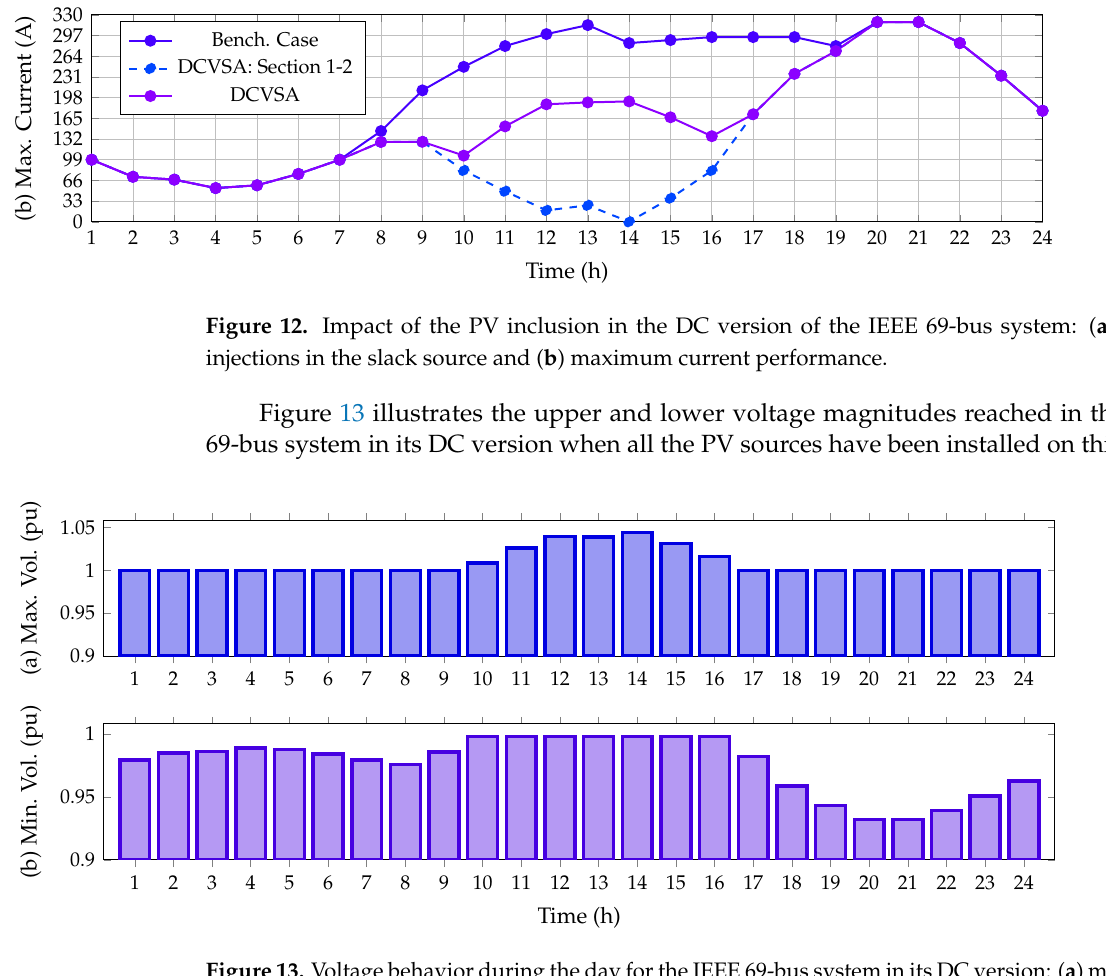
Figure 13. Voltage behavior during the day for the IEEE 69-bus system in its DC version: ( a ) maximum voltage magnitude, and ( b ) minimum voltage